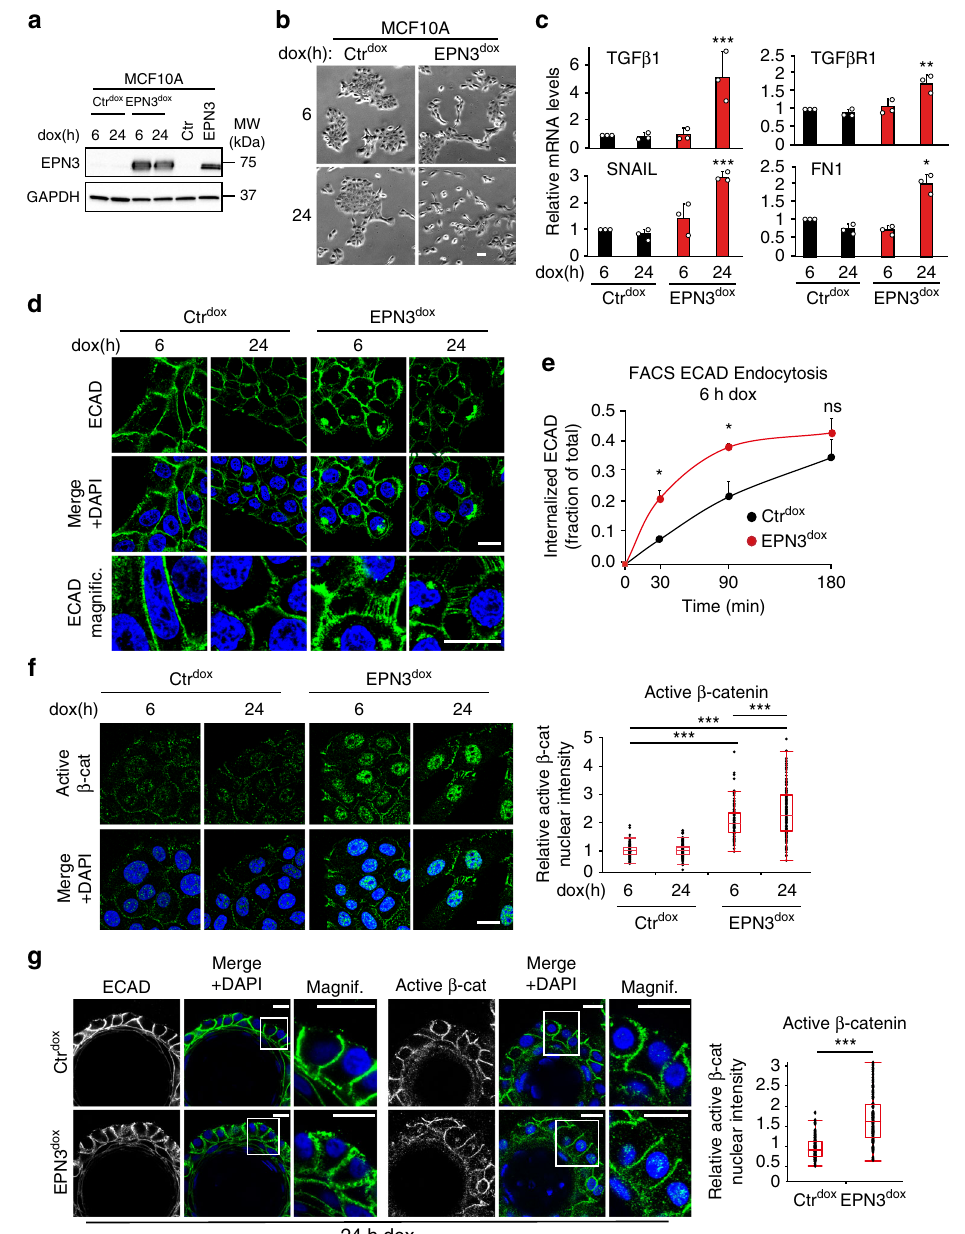
Fig. 7 ECAD accelerated endocytosis is the initial event in EPN3-driven EMT. a MCF10A-Ctr cells were infected with pSLIK-empty vector (Ctr dox ) or pSLIK-EPN3 (EPN3 dox ) and treated for 6 h or 24 h with 200 μ g ml − 1 doxycycline (dox). Lysates were subjected to IB analysis with the indicated Ab. GAPDH, loading controls. Lysates of MCF10A-Ctr and MCF10A-EPN3 were loaded in parallel as controls. Right, MW markers. b Phase-contrast microscopy of cells as in ( a ). Bar, 60 μ m. c RT-qPCR analysis of mRNA expression of the indicated genes in cells as in ( a ). Mean relative mRNA expression compared with MCF10A-Ctr, ± S.D. is reported ( n = 3, each performed in technical triplicates). P value, each pair Student ’ s t test, two-tailed. d IF staining of ECAD (green) in cells ( a ). Blue, DAPI. Bar, 20 μ m. e Time course of ECAD internalization measured by FACS analysis in MCF10A-Ctr dox and -EPN3 dox cells treated with dox for 6 h. Data are reported as fraction of mean fl uorescence intensity of internalized ECAD signal over the total, ± S.D. ( n = 3). P values, Student ’ s t test two-tailed. f Left, representative confocal images of the indicated cells dox-induced for 6 h and 24 h, and stained for active β -catenin. Blue, DAPI. Bar, 20 µ m. Right, box plot analyses of relative nuclear fl uorescence intensity of active β -catenin per cell in MCF10A-Ctr dox 6 h ( N = 222), MCF10A- Ctr dox 24 h (N = 323), MCF10A-EPN3 dox 6 h ( N = 98) and MCF10A- EPN3 dox 24 h cells ( N = 144) in a representative experiment ( n = 3). Data were normalized on the median value of nuclear fl uorescence intensity in the MCF10A-Ctr dox 6 h sample. P value, each pair Student ’ s t test, two-tailed. g Left, acini grown in 3D on top of Matrigel for 13 days were treated for 24 h with doxycycline and then subjected to IF with the indicated Ab. Blue, DAPI. Bar, 20 μ m. Right, box plot of relative nuclear fl uorescence intensity of active β -catenin per cell in a representative experiments of two independent replicates. Data were normalized on the median value of nuclear fl uorescence intensity in the MCF10A-Ctr dox 24 h sample. MCF10A- Ctr dox ( N = 86) and MCF10A- EPN3 dox cells ( N = 91). P value, each pair Student ’ s t test two-tailed. Source data are provided as a Source Data fi